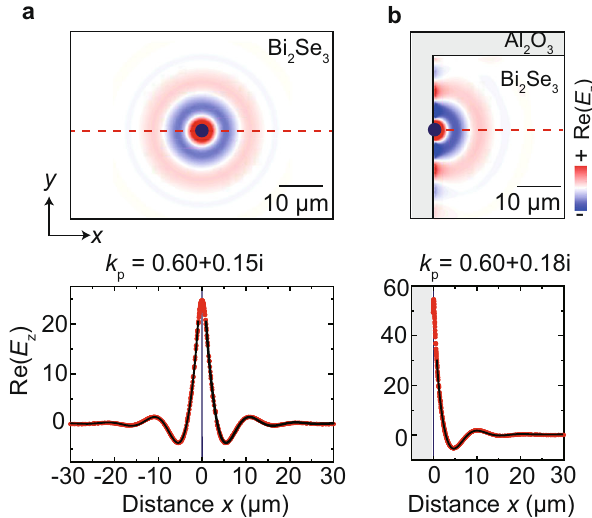
Fig. 3 Simulation of the near- fi eld distribution of polaritons launched by a dipole source in a conductivity sheet. The conductivity was obtained from = 0.55 + 0.17 i μ m − 1 . a Dipole source is located far away Eq. (2) with k p from edges. b Dipole source is located at the sheet edge. The lower panels show the electric fi eld along the horizontal red dashed line in upper panel (red data). The black lines of the lower panels show fi ts according to a ffiffiffi p (cid:6) (cid:7) x radially propagating damped wave, Re Ae ik p x = . The height of the dipole above the sheet is 1.5 μ m and the electric fi eld was calculated in a height of 200